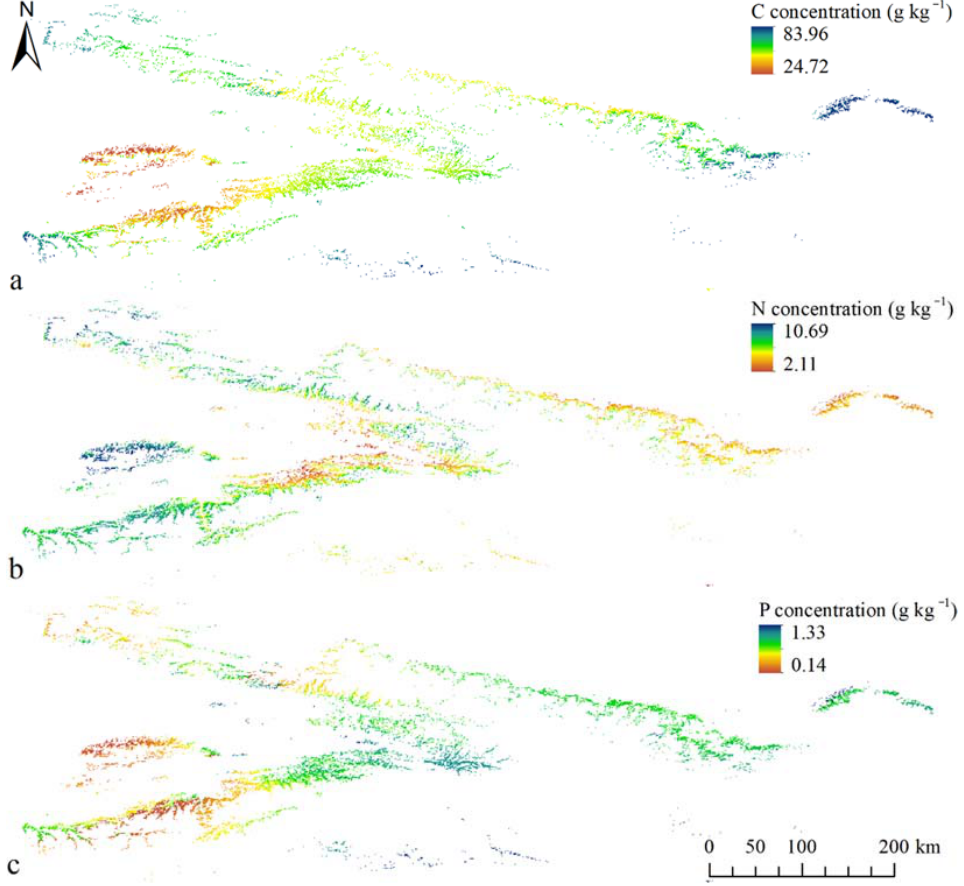
Figure 2. Modeled spatial distribution of soil C ( a ), N ( b ) and P ( c ) in the P. schrenkiana forest. C concentration was highest in the eastern part of the study area, while the central and southwestern parts corresponded to relatively lower C concentrations (Figure 2a).